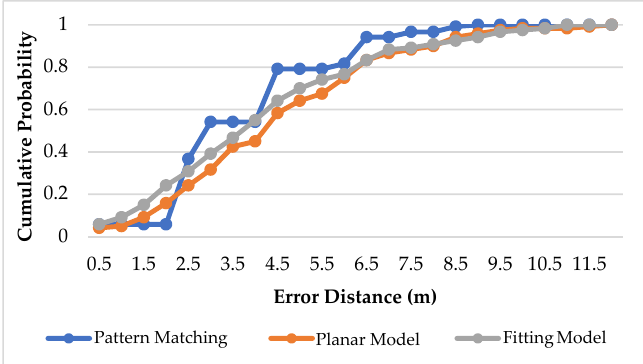
Figure 23. CDF for Optimal Area in Basketball Court.